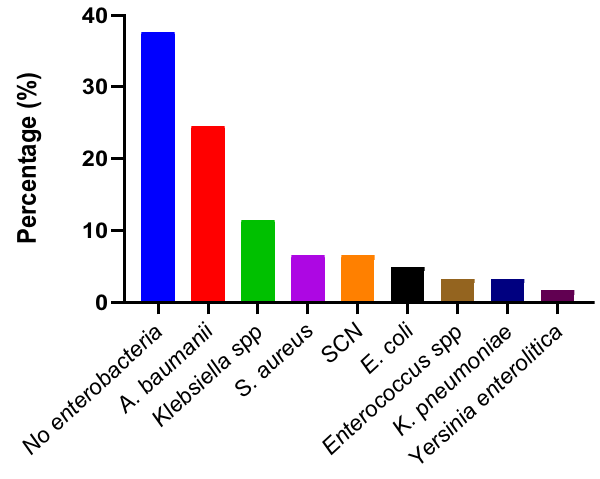
Fig. 2 Bacterial species isolated from hospital effluent